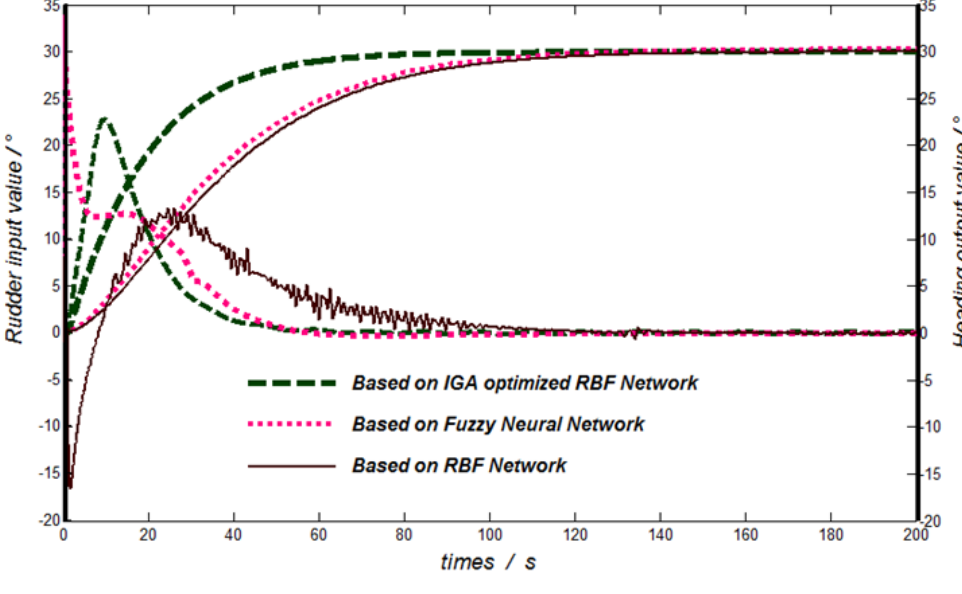
Figure 5. Results of the comparison experiment.